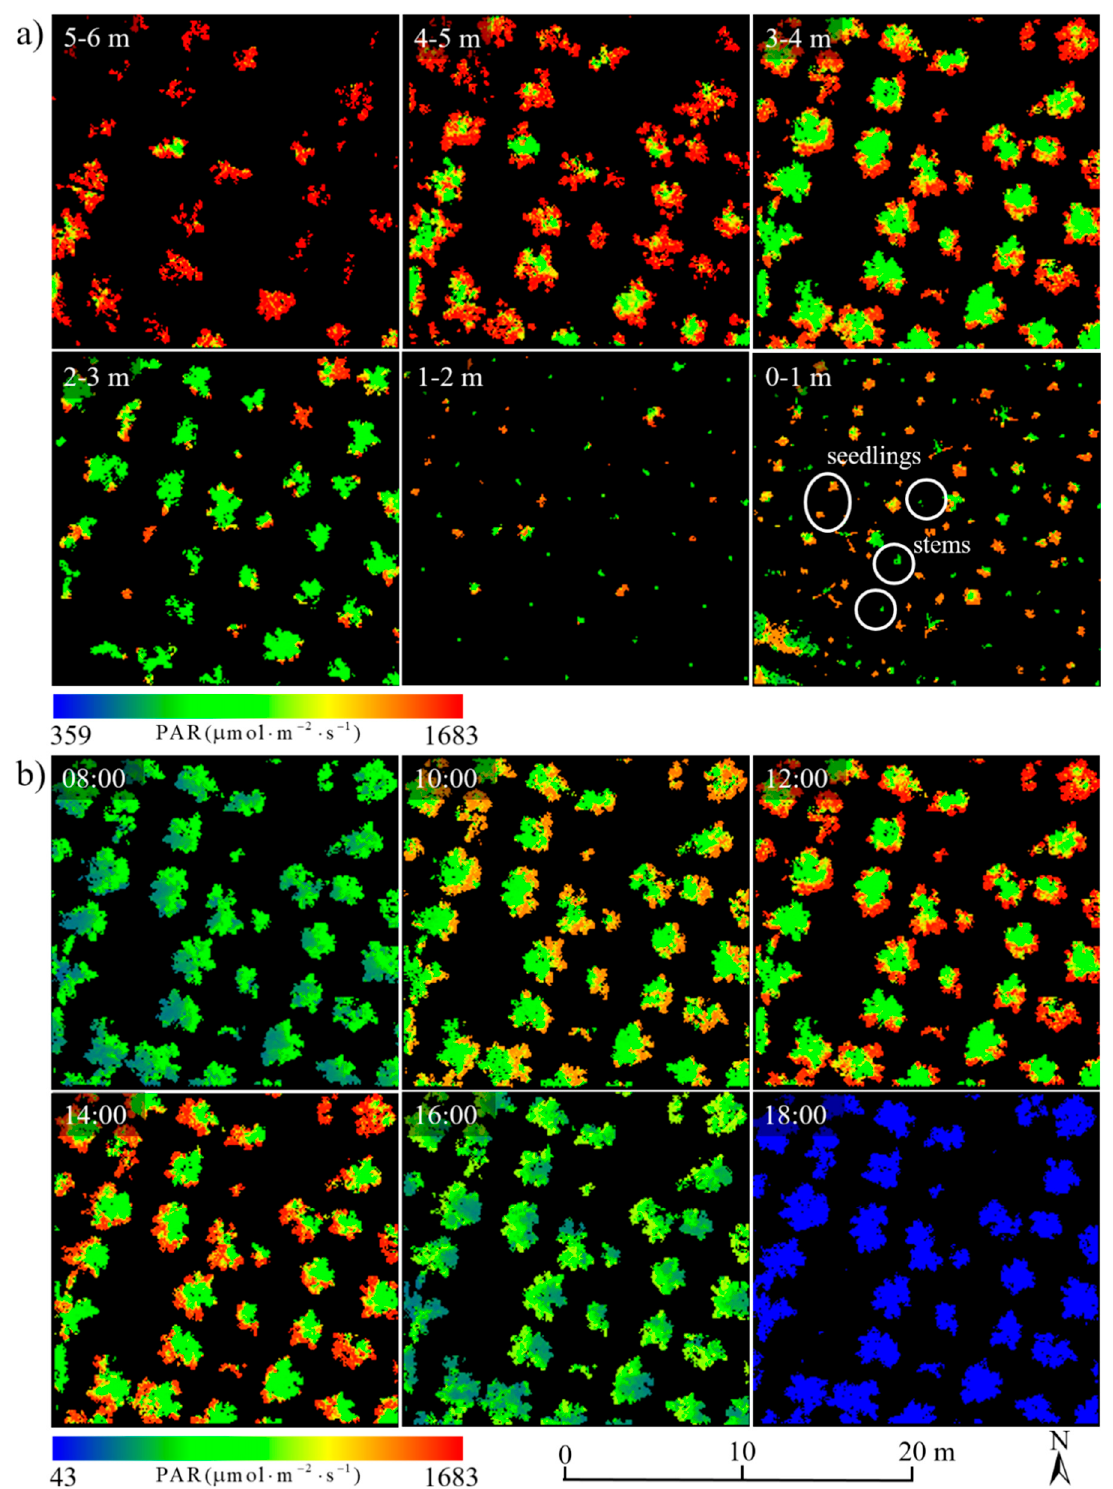
Figure 6. The vertical spatial distributions of PAR within a forest canopy at noon (inset a ) and temporal variations of PAR with the height ranging from 3 m to 4 m (inset b ) based on the fused point data.